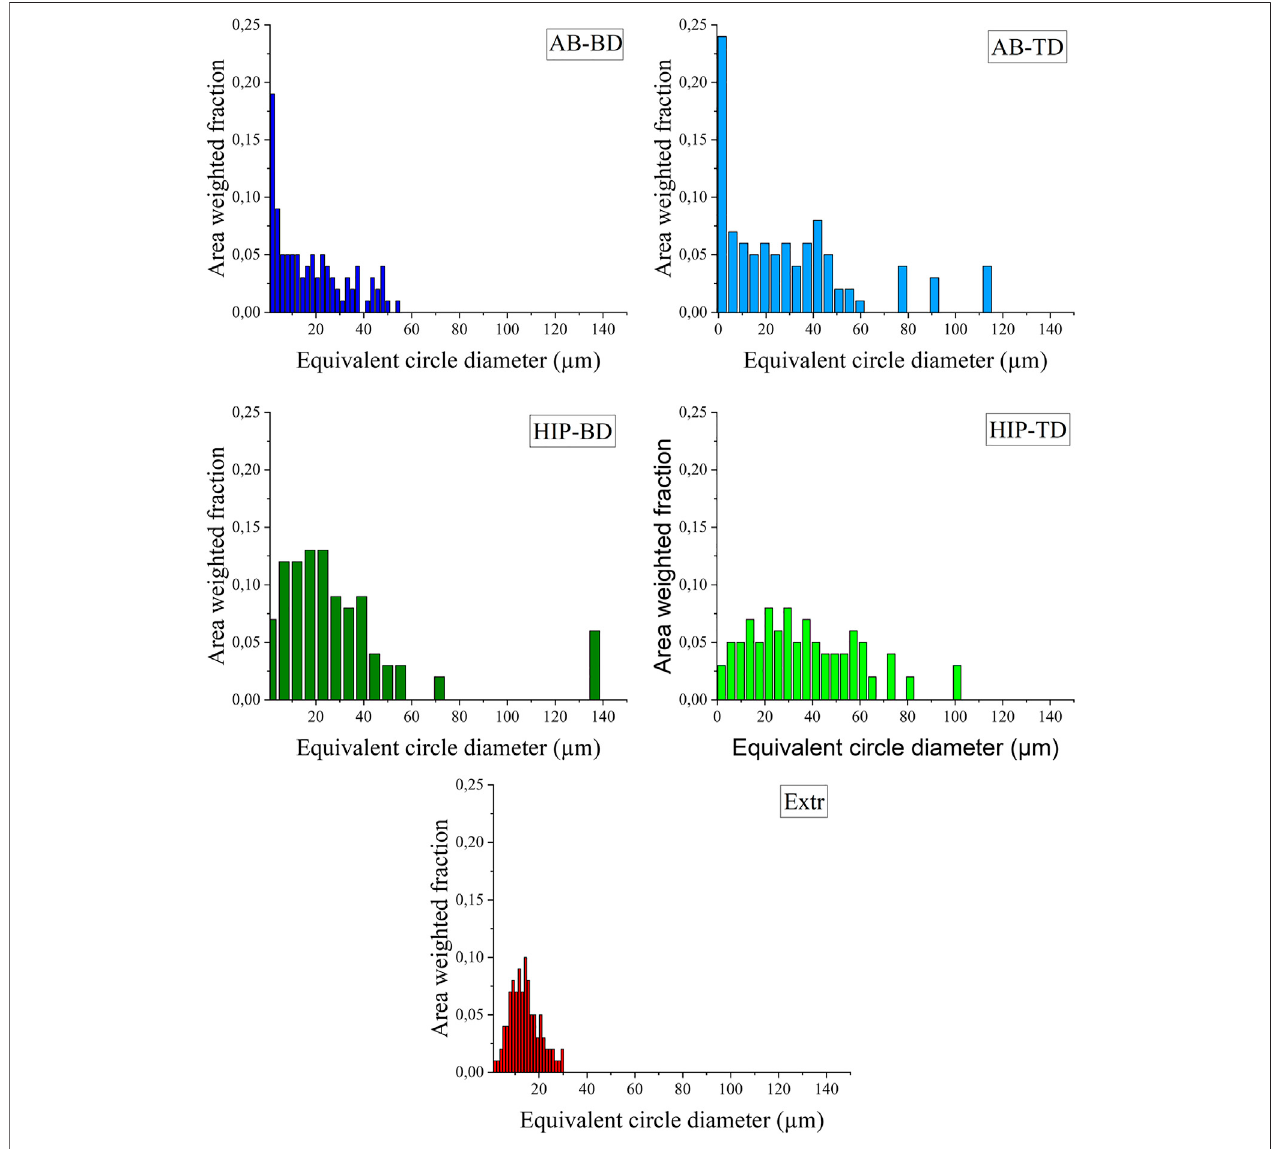
FIGURE6| Grainsizedistribution presentedasequivalentcirclediameterplottedagainsttheareaweightedfractionforthe (A) AB-BD, (B) AB-TD, (C) HIP-BD, (D) HIP - TD and (E) Extr material.